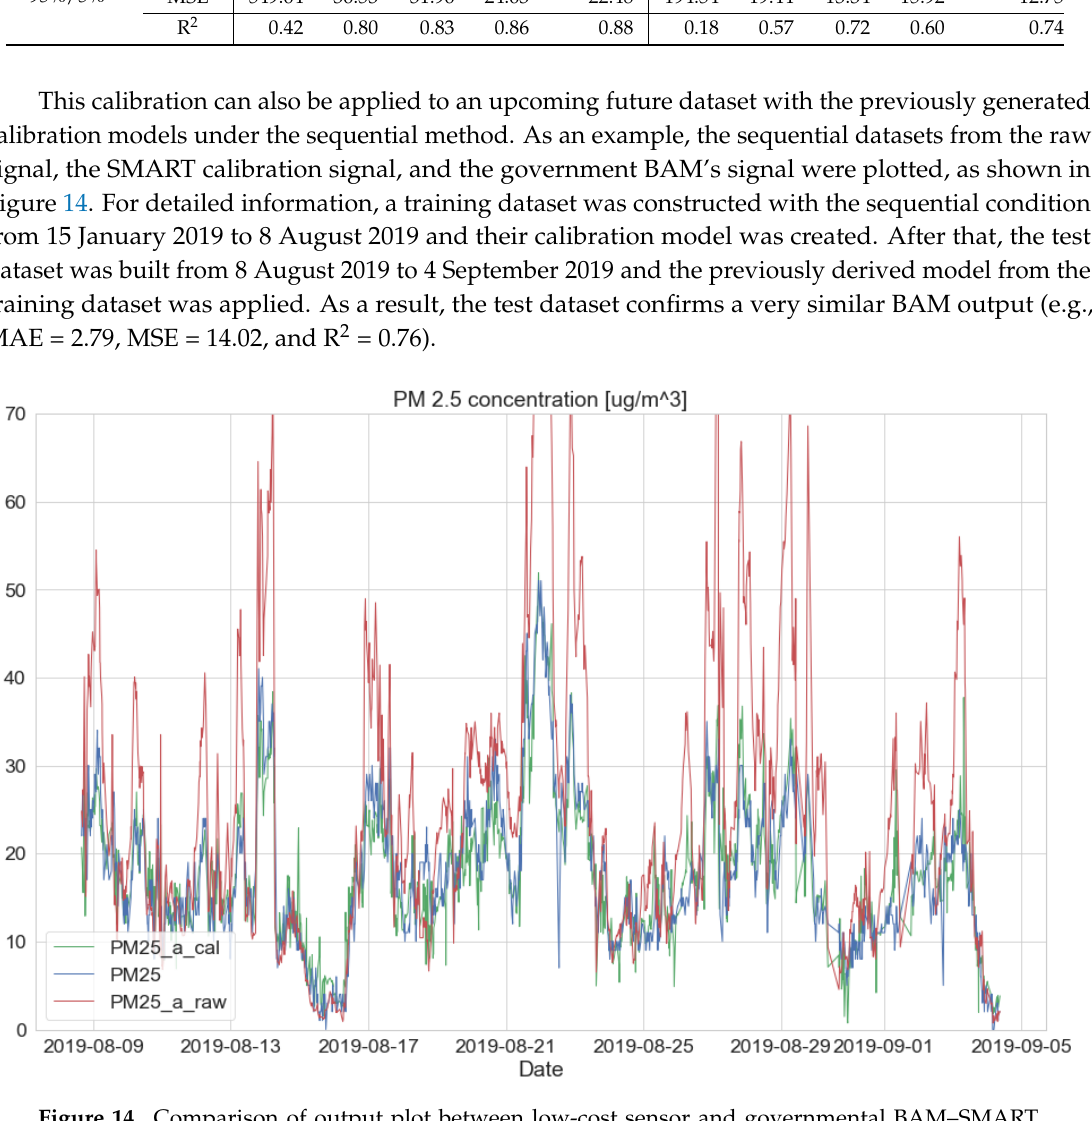
Figure 14. Comparison of output plot between low-cost sensor and governmental BAM–SMART calibration signal (green line)/BAM signal (blue line)/raw signal (red